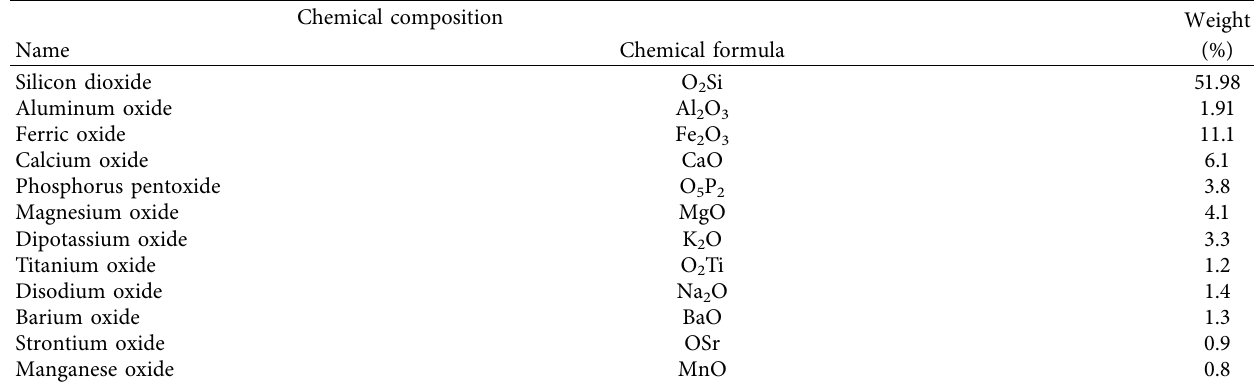
Table 2: Chemical properties of subgrade soil. Chemical